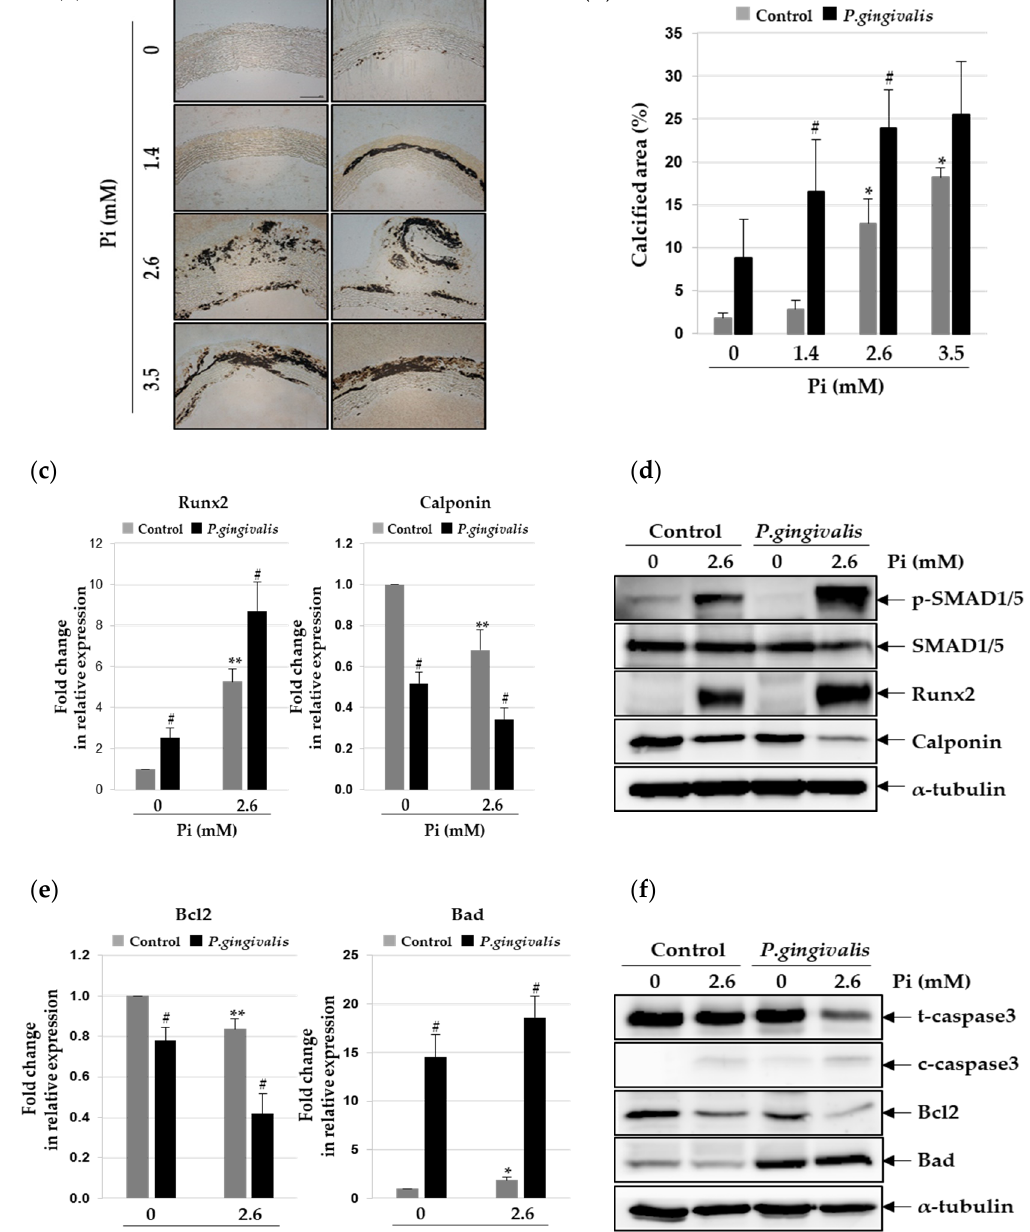
Figure 4. E ff ect of P. gingivalis on Pi-induced vascular calcification in aortic culture. P. gingivalis -infected rat aortas were cultured in calcification medium (2.6 mM) for eight days. ( a ) Calcified lesions were examined by von Kossa staining. Magnification is 200 × . ( b ) The percentage of the calcified area was calculated using Calcification Analyzer Ver2. * p < 0.01 vs. 0 mM Pi, # p < 0.05 vs. control, one-way ANOVA followed by a Student’s t-test. ( c , e ) Total RNA was isolated from calcified rat aortas and analyzed by real-time RT-PCR using primers specific for rat Runx2, calponin, Bcl2, and Bad. The expression level of the control (untreated) was set to 1, and the values were normalized to the β -actin mRNA levels. * p < 0.05; ** p < 0.01 vs. 0 mM Pi, # p < 0.01 vs. control, one-way ANOVA followed by a Student’s t-test. Data shown are the mean ± SD, obtained for at least three independent experiments. ( d , f ) Phospho-SMAD1 / 5, SMAD1 / 5, Runx2, calponin, total / cleaved-caspase3, Bcl2, Bad, and α -tubulin protein levels were examined by Western blotting using their corresponding antibodies.